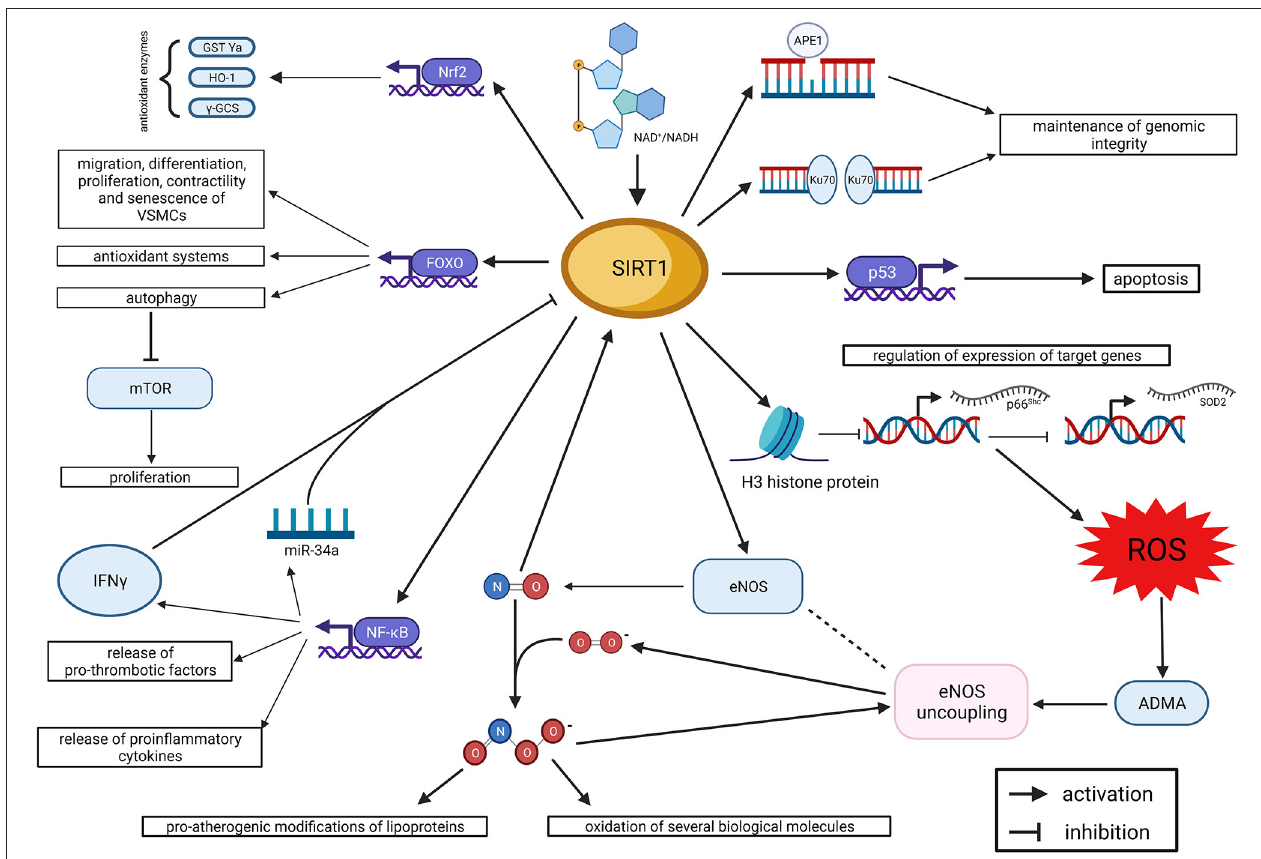
FIGURE 1 | SIRT1 and endothelial dysfunction. Summary of molecular mechanisms (created with BioRender.com). ADMA, asymmetric dimethyl-arginine; APE1, apurinic/apyrimidinic endonuclease 1; eNOS, endothelial nitric oxide synthase; FOXO, forkhead box O class; γ -GCS, γ -glutamylcysteine synthetase; GST Ya, glutathione S-transferase Ya; HO 1, heme oxygenase 1; IFN γ , interferon γ ; mTOR, mechanistic target of Rapamycin; NAD: nicotinamide adenine dinucleotide; NF- κ B, nuclear factor kappa-light-chain-enhancer of activated B cells; Nrf2, nuclear factor erythroid 2—related factor 2; ROS, reactive oxygen species; SIRT1, Sirtuin 1; SOD2, superoxide dismutase